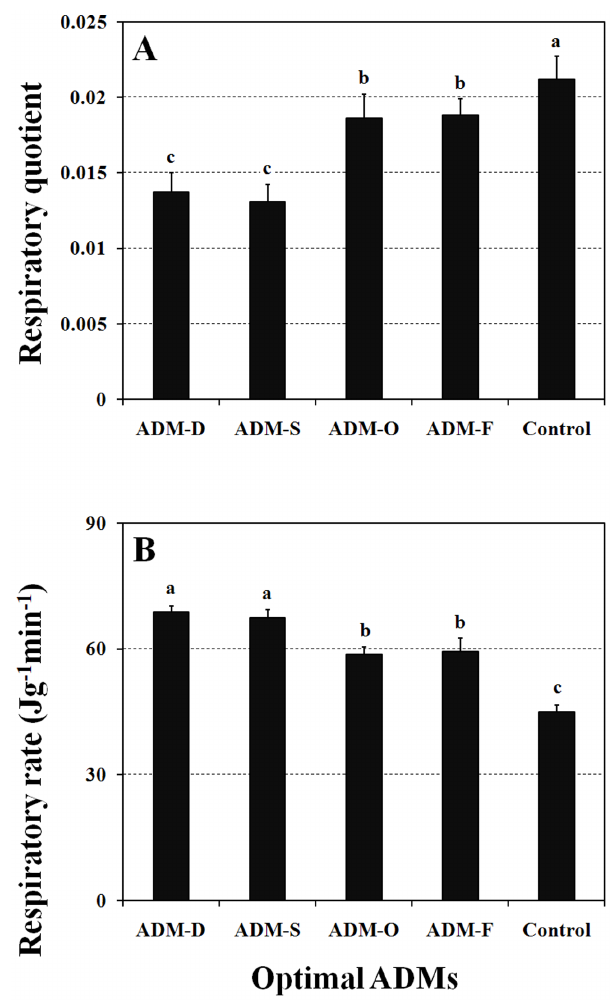
Figure 3. Respiratory quotient and rate of O.sauteri fed with either different optimal ADMs or T.cinnabarinus . The columns and bars represent mean + SE. The letters at the top of the columns indicate significant differences based on the LSD test (P , 0.05). the control group (Figure 6-A, F = 8.07, d.f. =4,70, P , 0.01). In contrast, optimal ADM treatments did not influence the number of prey remaining compared with the control group (Figure 6-A, F = 1.08, d.f. = 4,70, P= 0.384). The results shown in Figure 6-B indicate that the number of remaining F. occidentalis was not influenced significantly by the optimal ADM recipes, either at 24 h (F= 0.227, d.f. =4,70, P =0.922) or 48 h (F= 0.354, d.f. = 4,68, P = 0.84). Population dispersal in greenhouses. The number of O. sauteri observed on host plants was only significantly different in section 2 at 24 h among all optimal ADM and control groups (Figure 7-A, F section1 = 0.843, P section1 = 0.505; F section2 =7.908, P section2 , 0.01; F section3 = 0.235, P section3 =0.917; all d.f. = 4,45). Compared with the 24-h checkpoint, observations at 48 h showed that the number of O. sauteri in sections 2 and 3 were significantly influenced by diet type (Figure 7-B, F section1 =0.443, P section1 = 0.771; F section2 = 4.23, P section2 , 0.01; F section3 =6.668, P section3 , 0.01; all d.f. = 4,45). Finally, the number of O. sauteri did not differ among diet types in all three sections after 72 h (Figure 7-C, F section1 = 0.908, P section1 =0.467; F section2 =1.124,